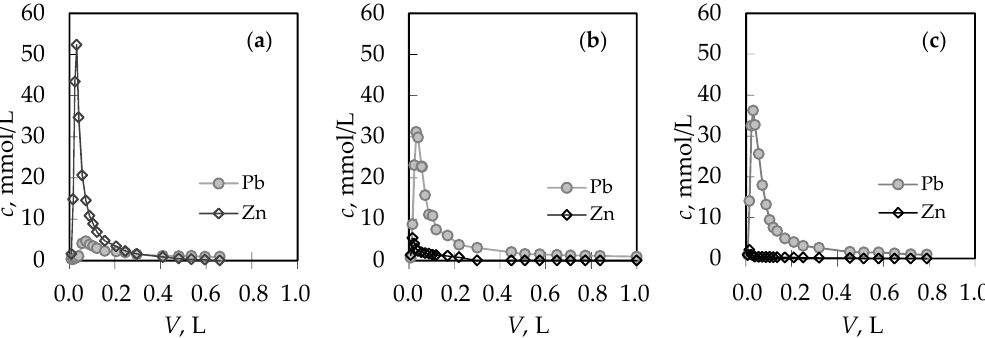
Figure 7 . Regeneration curves for each metal ion obtained after service cycles with different Pb/Zn ratios: ( a ) 0.19; ( b ) 1.07; ( c )